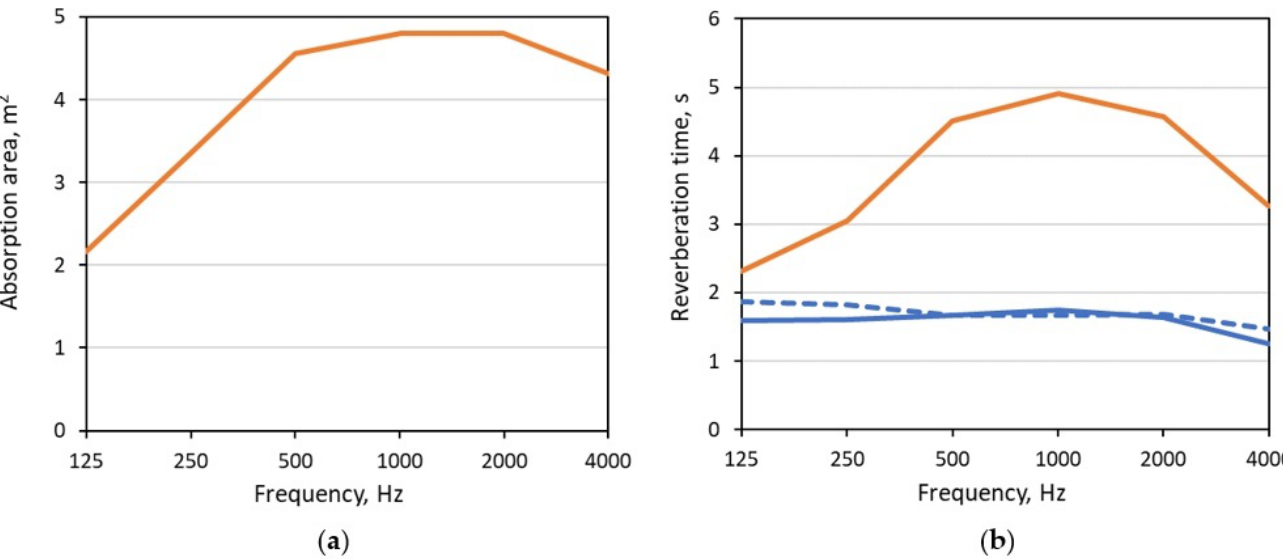
Figure 9. Absorption area ( a ) of baffles on the ceiling in the food court FC2 and reverberation time ( b ) measured before (red) and after (blue) reconstruction in comparison with the expected one (blue, dotted).